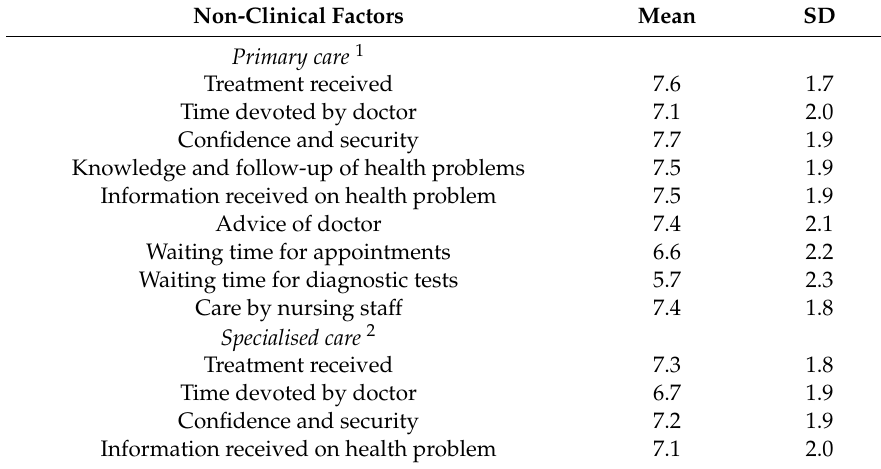
Table 4. Descriptive statistics of non-clinical factors by public health service in Spain in